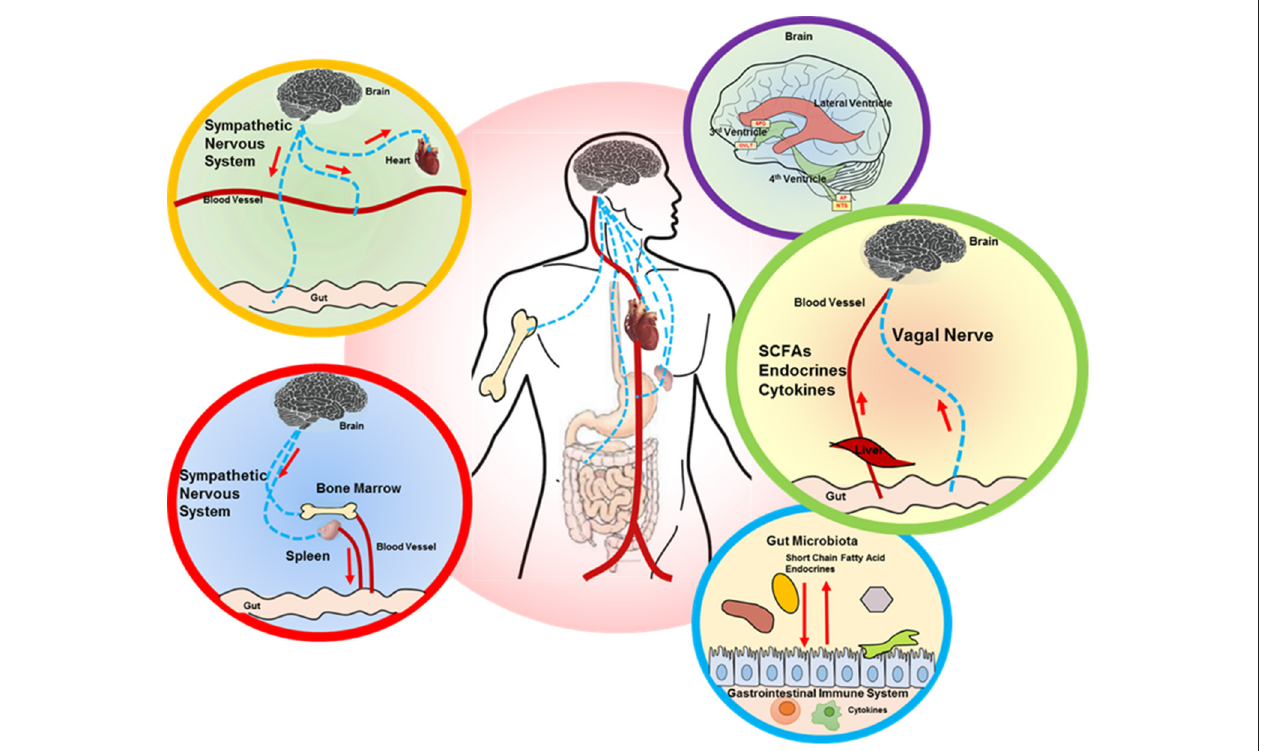
FIGURE 1 | Proposed brain-gut axis in hypertension. A number of signaling mechanisms connect the gut and brain, including the following: (i) descending autonomic innervation of cardiovascular and GI systems (yellow and red circle outlines) and sympathetic regulation of the immune system (red circle outline), which also impacts the gut (red and blue circle outlines); (ii) ascending connections, including circulating factors (SCFAs, endocrines, cytokines) that are perceived by the brain circumventricular organs (CVOs), while vagal signaling from the gut is processed in the NTS (purple and green circle outlines). The interaction between gut microbiota and GI system is shown in the blue circle outline. SCFA, short chain fatty acid; SFO, subfornical organ; OVLT, organ vasculosum of lamina terminalis; AP, area postrema; NTS, nucleus tractus